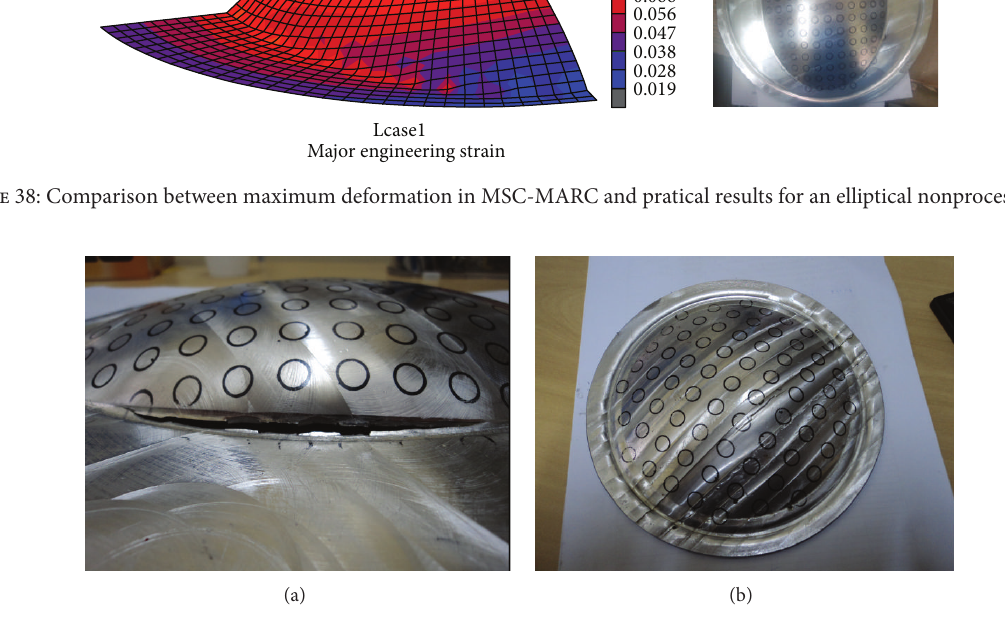
Figure 39: Crack on processed sheets after practical bulge tests. (a) Elliptical sheet and (b) circular